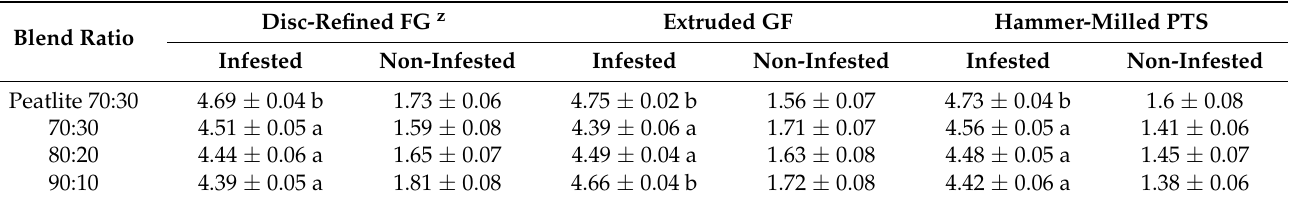
Table 5. Mean damping-off disease severity ± standard error in R. solani -infested and non-infested pots seven days post-seeding in wood treatment blended with peat at three ratios compared to a peat:perlite